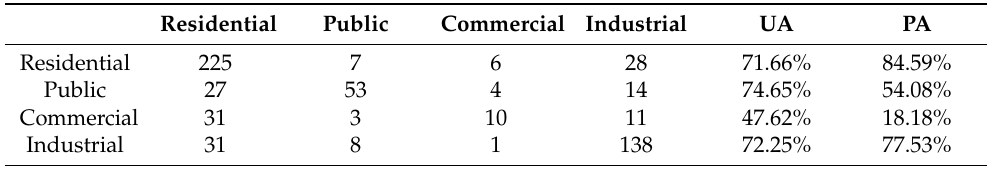
Table 10. Confusion matrix of grid and parcel exchange experiment